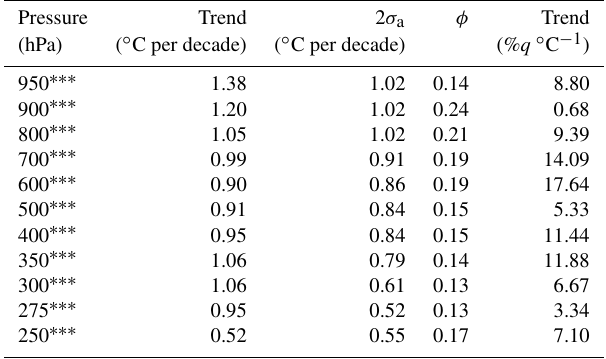
Table 3. Table of temperature trend calculations for each pressure layer using the operational radiosondes. The second column is the temperature trend in units of degrees per decade, the third column is the 2 σ a trend uncertainty in units of degrees per decade, the fourth column is the autocorrelation coefficient at lag 1, and the fifth col- umn is the per cent change in specific humidity per degree